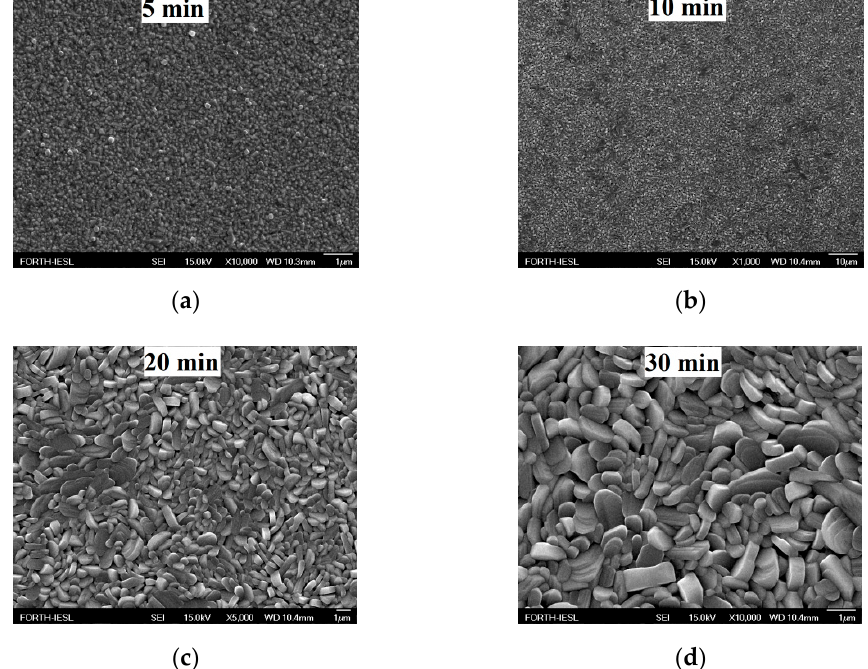
Figure 3. FE-SEM images of V 2 O 5 grown by AACVD at 400 °C for growth periods of ( a ) 5 min, ( b ) 10 min, ( c ) 20 min, and ( d ) 30 min and annealed at 600 °C for 3 h.